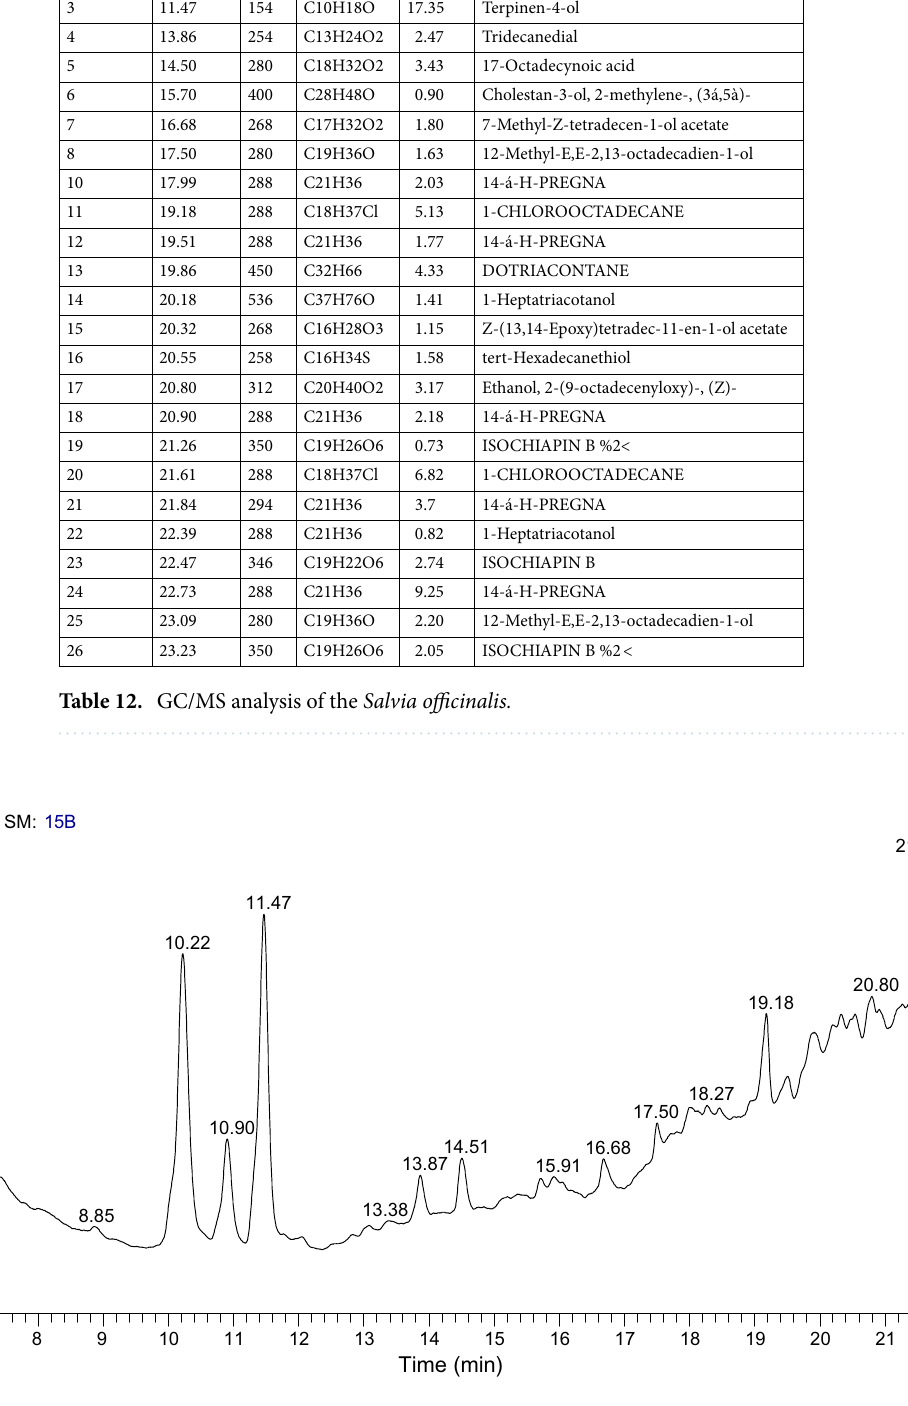
Figure 6. GC/MS analysis of Salvia